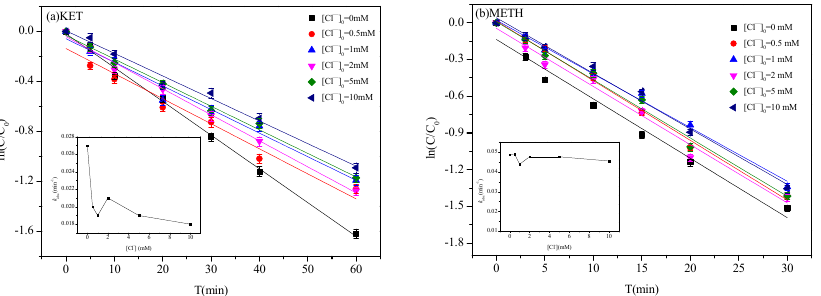
Figure 8. E ff ect of Cl − on KET ( a ) and METH ( b ) degradation in the UV / H 2 O 2 system. Conditions: (KET) 0 = (METH) 0 = 100 µ g / L, (H 2 O 2 ) 0 = 500 µ M, pH 0 = 7.0, T = 25 ± 1 ◦